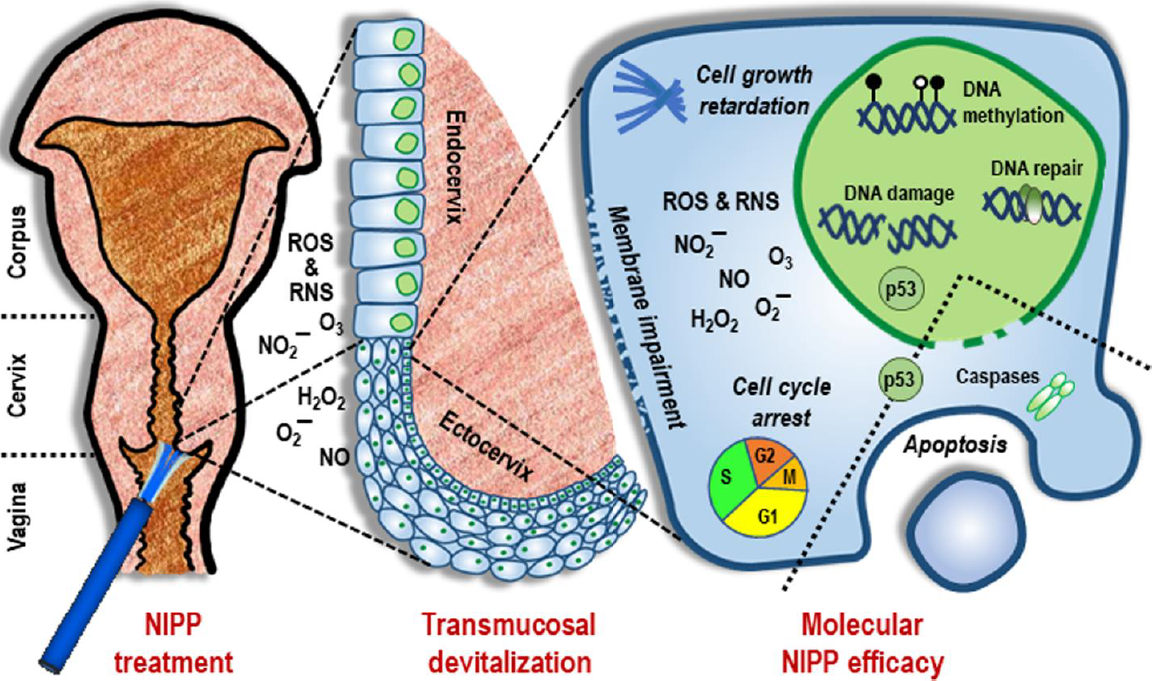
Figure 5. General summary of the antineoplastic NIPP response. The reactive species generated by NIPP cause a transmucosal increase in intracellular ROS and RNS, particularly through NIPP-mediated impairment of the cytoplasmic membrane. As a result, ROS and RNS activate various intracellular response pathways, primarily alterations in genomic methylation patterns and signal transduction cascades involved in the DNA double-strand break response and p53-associated apoptosis. This is